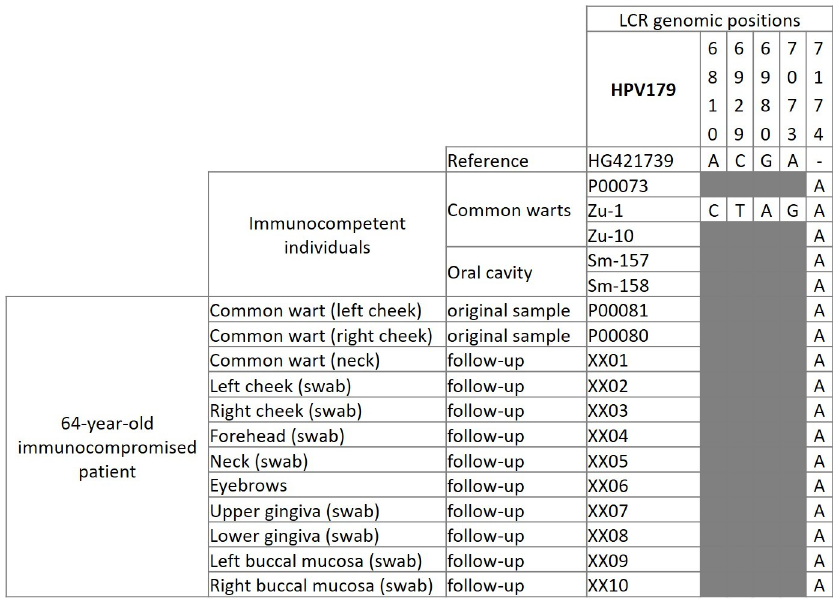
Fig 1. Long control region viral variants of human papillomavirus type 179 in 12 samples obtained from an immunocompromised patient and five independent samples obtained from immunocompetent individuals (GenBank acc. nos. MW574219 –MW574235). The top of the frequency table shows the nucleotide sites of substitutions/insertions in the HPV179 isolates investigated according to the HPV179 reference genome. Nucleotide sites where no substitutions or deletions were observed are marked